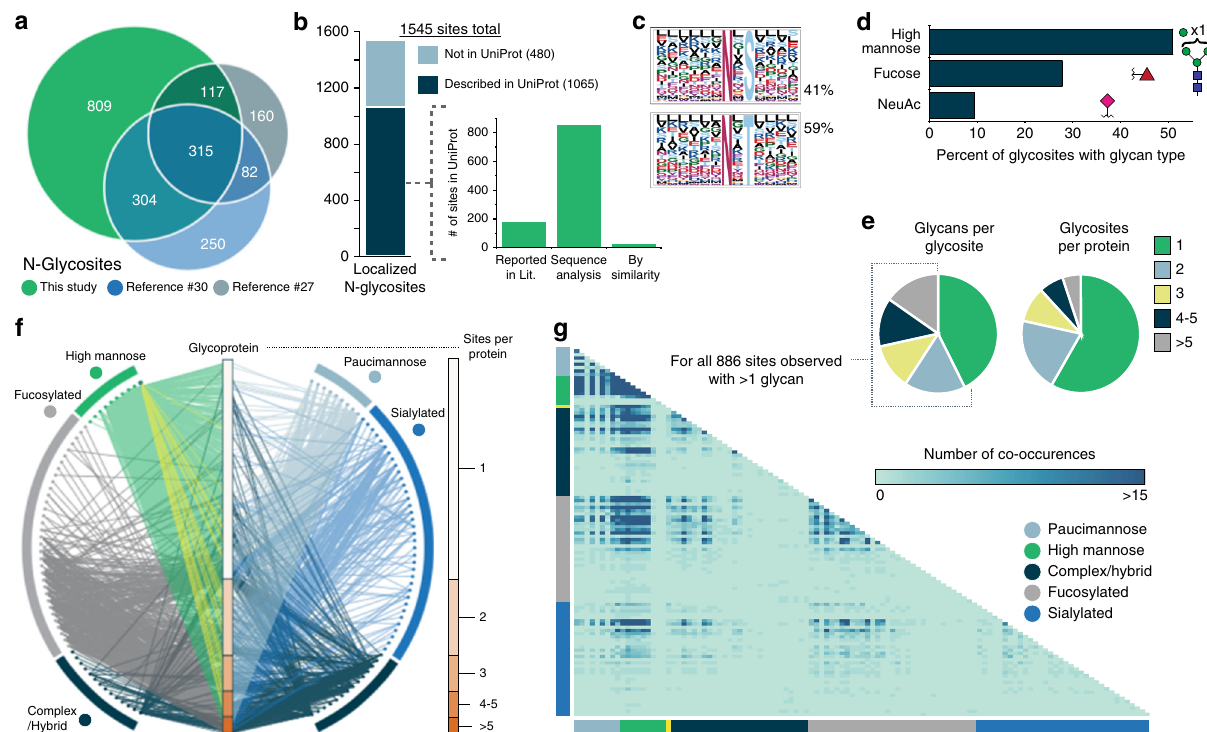
Fig. 2 Characteristics of glycosites identi fi ed with AI-ETD. a Overlap of mouse brain N-glycosites identi fi ed in this study with those from Liu et al. 30 and Trinidad et al. 27 studies. b Approximately 69% of identi fi ed glycosites are described as known glycosites in the UniProt database, and the majority of them have that description based on sequence analysis (i.e., prediction of glycosite based on the presence of the N-X-S/T sequon). c Sequence motifs for N- glycosites having either the N-X-S or N-X-T sequon and their relative percentage in the unique glycosites identi fi ed. d Percentage of total glycosites that had glycans of high mannose type or that contained a fucose or NeuAc residue. e Distribution of the number of different glycans seen at a given glycosite, i.e., the degree of glycan microheterogeneity (left), and the number of glycosites per glycoprotein identi fi ed (right). f A glycoprotein-glycan network maps which glycans (outer circle, 117 total) modify which proteins (inner bar, 771 total). Glycoproteins are sorted by number of glycosites (scale to the right). Glycans are organized by classi fi cation, and edges are colored by the glycan node from which they originate, except for mannose-6-phosphate which has yellow edges. See Supplementary Fig. 11 and Supplementary Table 1 for glycan identi fi ers. g A glycan co-occurrence heat map represents the number of times glycan pairs appeared together at the same glycosite, indicating which glycans contribute most to microheterogeneity of the >880 sites that had more than one glycan modifying